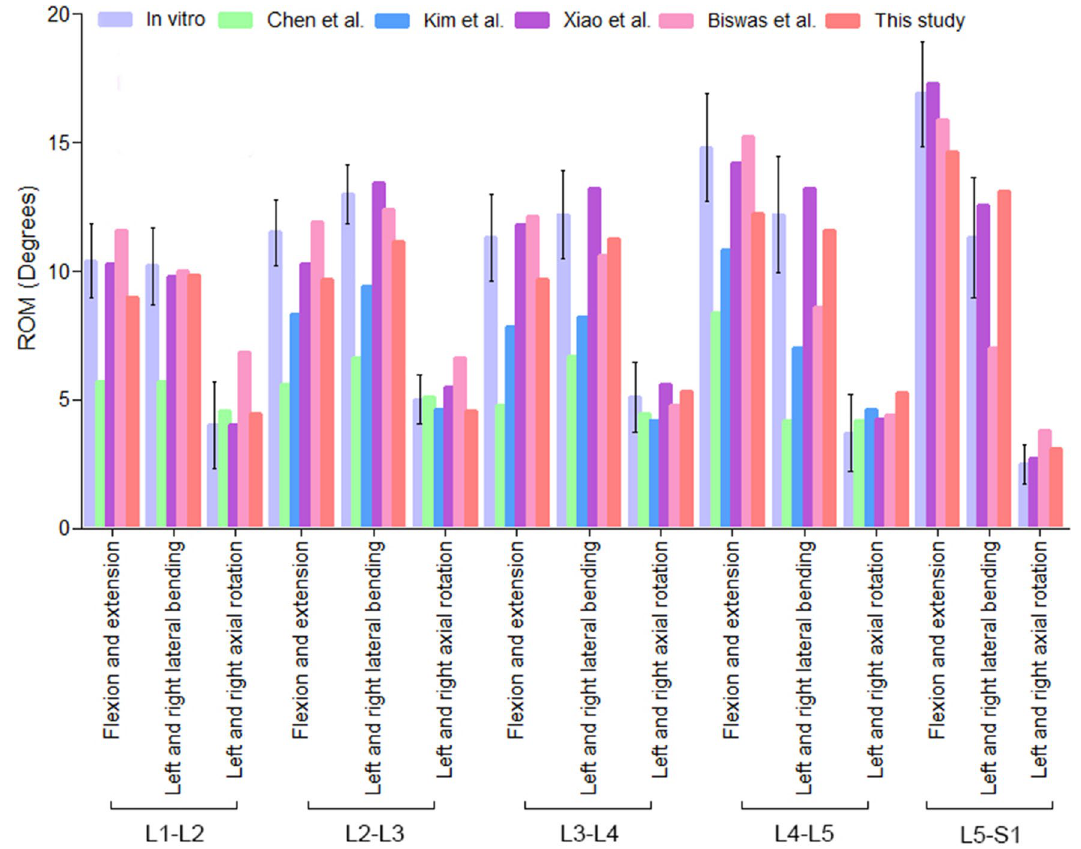
Figure 4. Comparison of ROM, between this study and the results reported by the previous